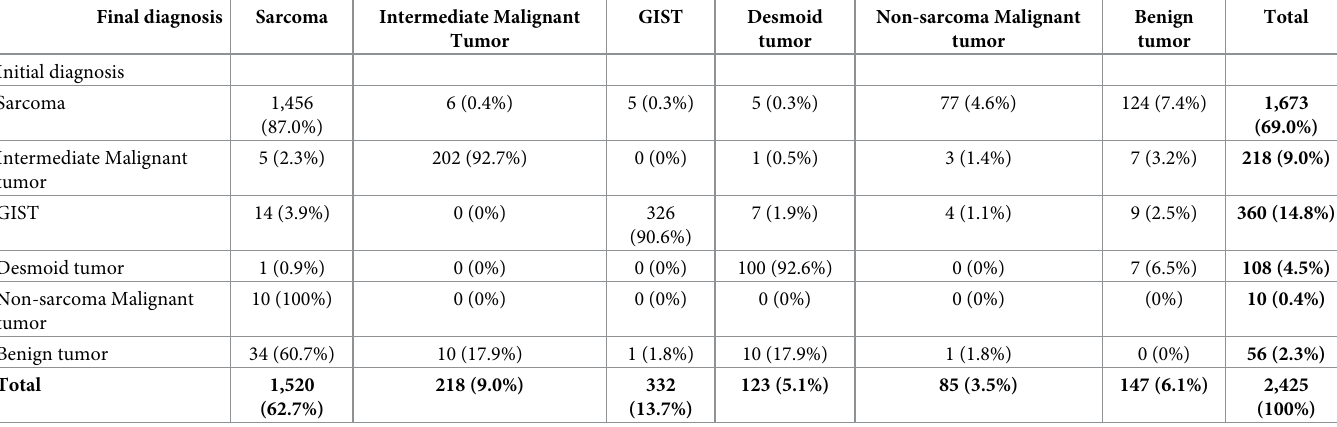
Table 3. Number of concordant and misdiagnoses according to the category of tumor (n =